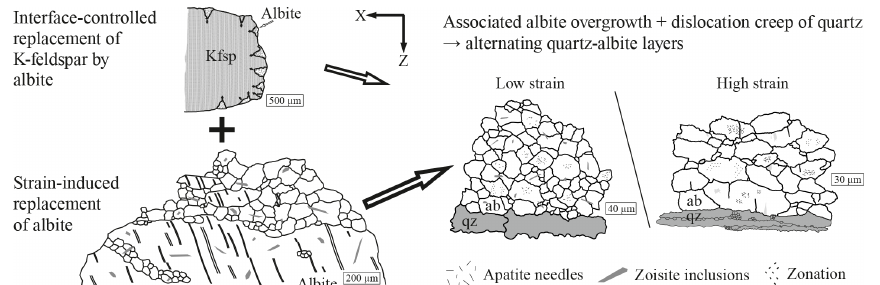
Figure 14. Conceptual sketch of the formation of the mylonitic albite matrix. The contribution of replacement of albite porphyroclasts by albite is larger than that of replacement of K-feldspar (see text for discussion).